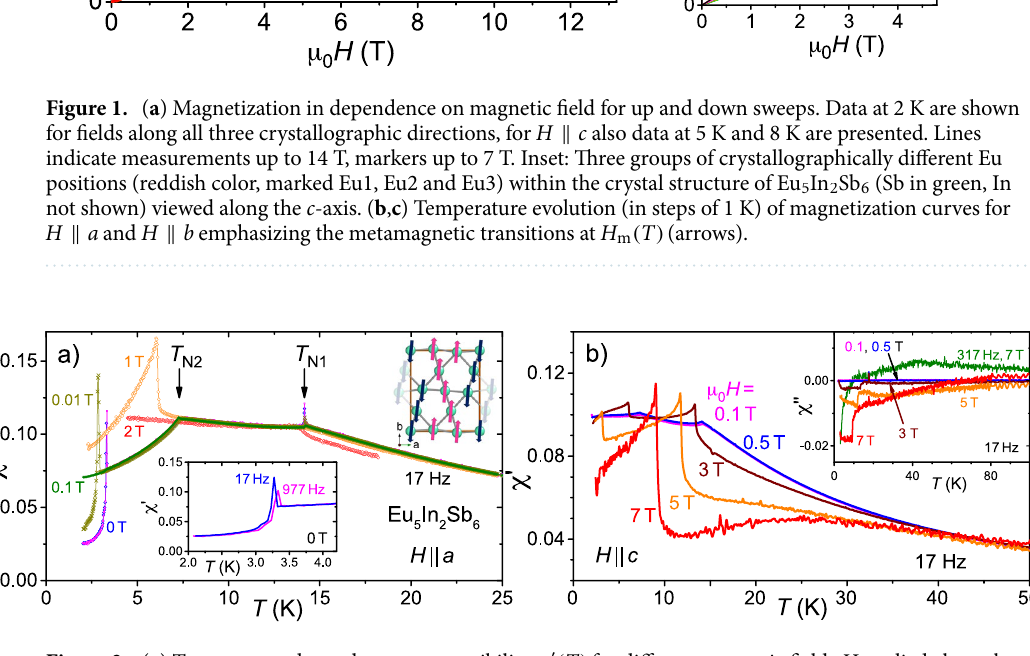
Figure 2. ( a ) Temperature dependent ac susceptibility χ ′ ( T ) for different magnetic fields H applied along the crystallographic a -axis illustrating the temperature shifts of the transitions with H . Lower inset: Slow T -sweep (0.1 K/min) reveals a small offset for different ac-field (2 Oe) drive frequencies for the low- T transition. Upper inset: suggested spin configuration. ( b ) χ ′ ( T ) for different H along the c -axis. Inset: Imaginary component of susceptibility, χ ′′ ( T ) for the same conditions. For comparison, χ ′′ ( T ) at 317 Hz and 7 T is shown. Different samples were measured in ( a ) and ( b